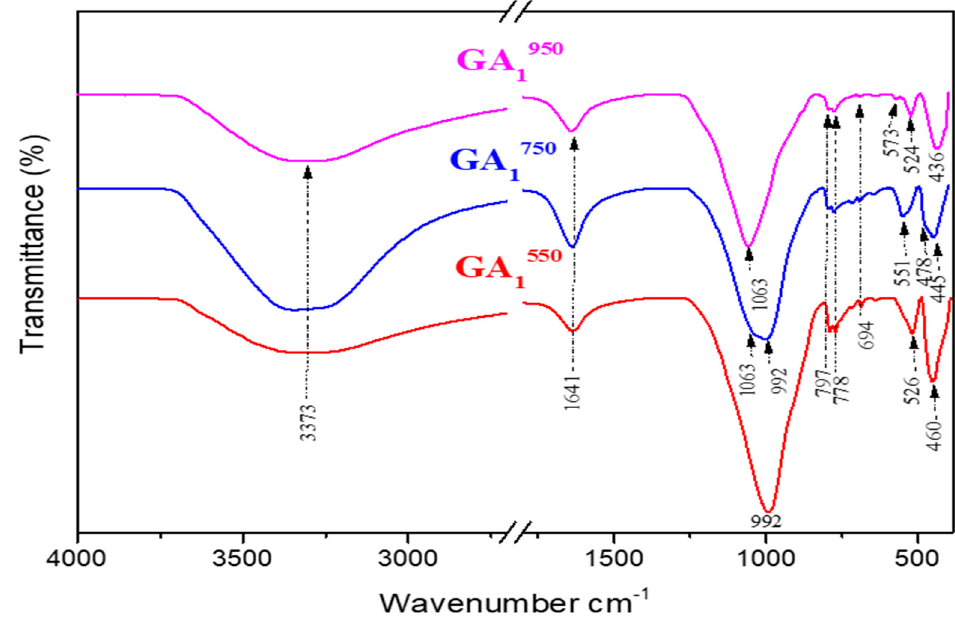
Figure 15. Infrared spectra of geopolymers synthesized from Tunisian clay calcined at different temperatures (GA 1550 , GA 1750 , GA 1950 ) aged 7 days.